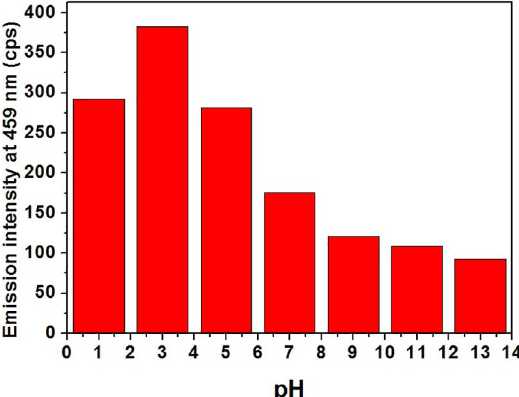
Figure 4. pH stability of C-dots colloidal